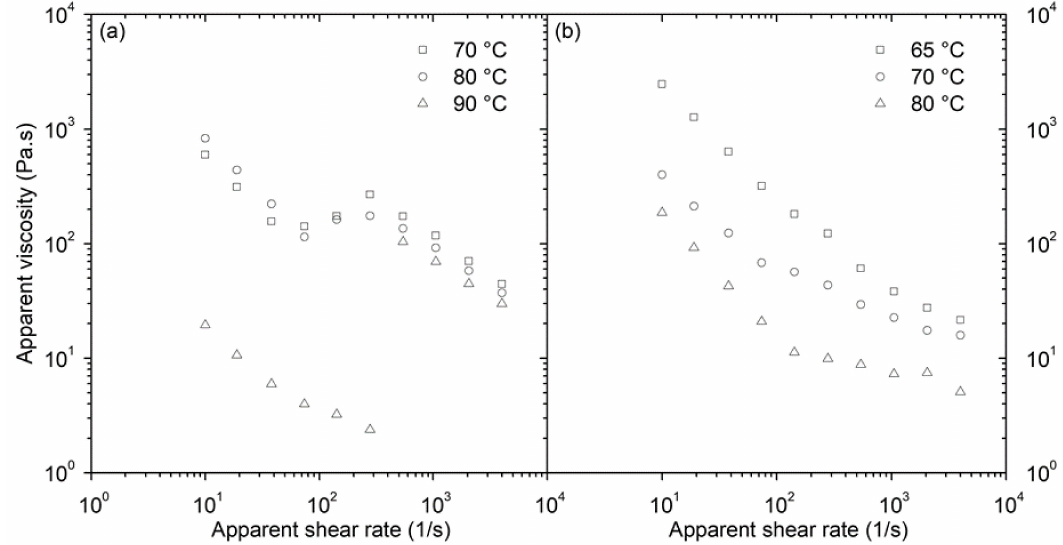
Figure 2. Apparent viscosity data of: ( a ) AW-based feedstock; ( b ) CW-based